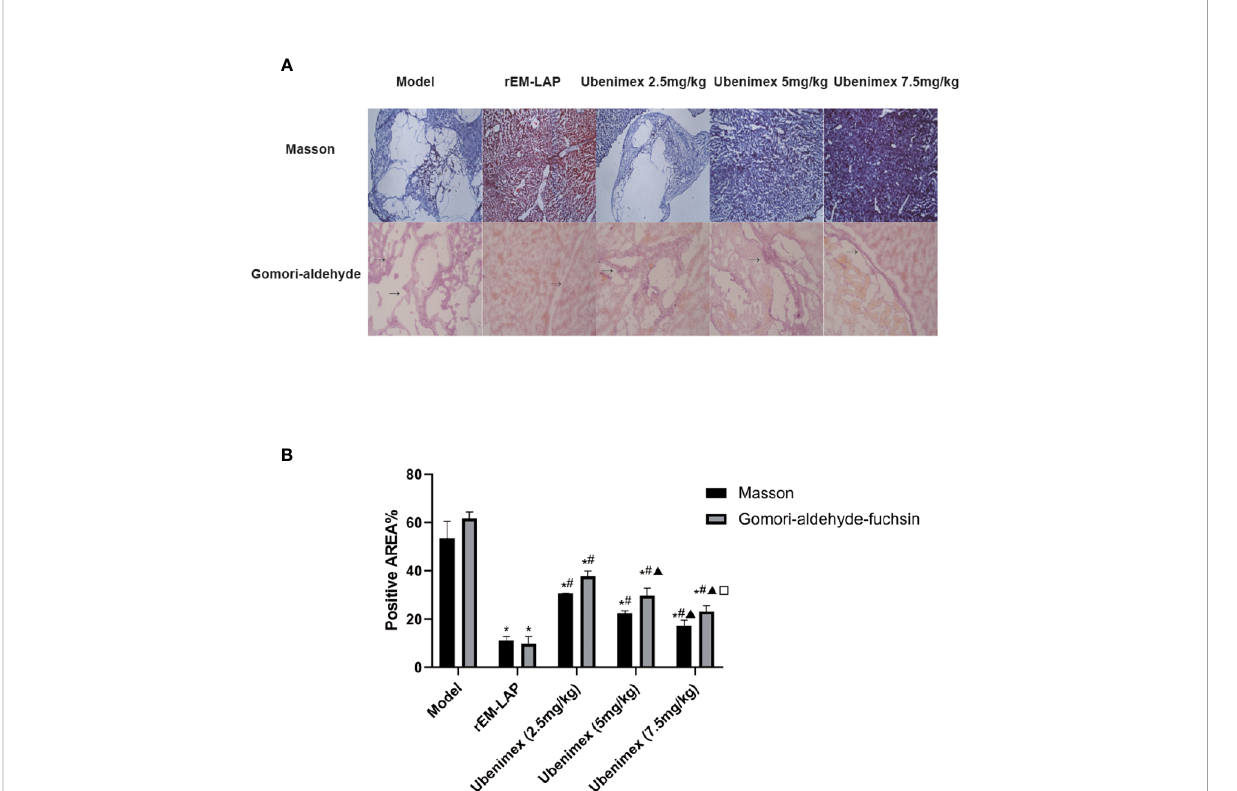
FIGURE 5 Treatment with rEM-LAP or Ubenimex inhibited the in fi ltration and fi brosis of cysts in livers of mice infected with E. multilocularis protoscoleces. (A) Representative Masson – stained and Gomori-aldehyde-fuchsin – stained cyst sections from mice treated with rEM-LAP, Ubenimex, and PBS (200×) (B) Positive staining area (%) is presented in each image. The results are obtained from several images of 3 mice for each speci fi c staining (* p<0.05 v.s. Model group; # p<0.05 v.s. LAP group; ▲ p<0.05 v.s. 5 mg/kg Ubenimex group; □ p<0.05 v.s. 2.5 mg/kg Ubenimex group. n=3, a